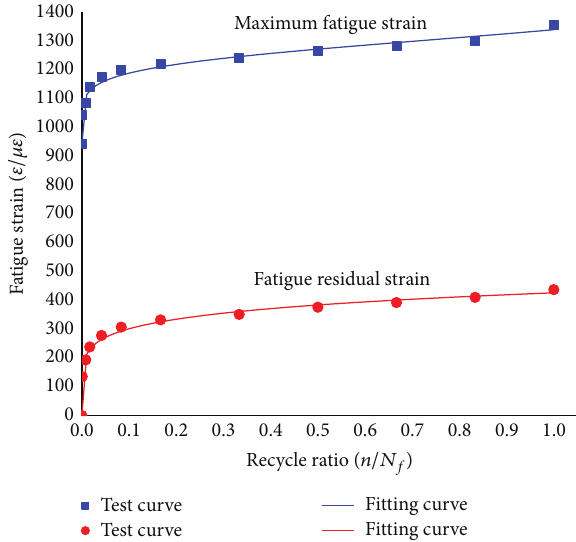
Test curve Test curve Figure 4: Testing and fitting results of fatigue strain of JL-3.